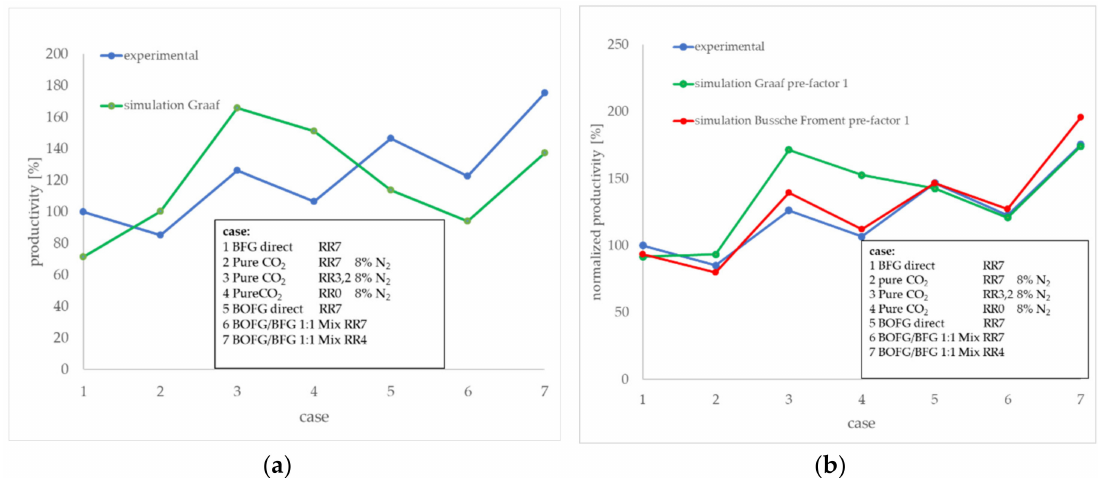
Figure 11. Comparison between experimental productivity and the process simulation results according to the Graaf kinetic with catalyst di ff usion limitation pre-factors adapted to an industrial catalyst ( a ) and comparison between the experimental results and simulation results according to two di ff erent kinetic approaches without lcatalyst di ff usion limitation pre-factors ( b